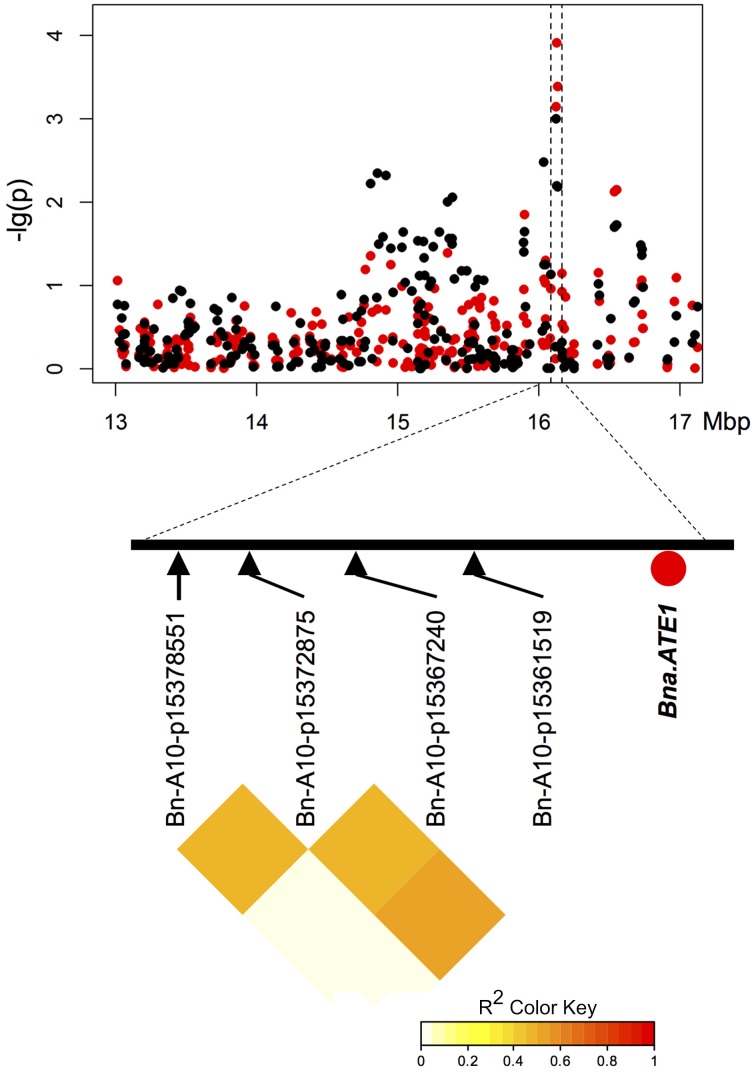
Manhattan plot describing marker-trait associations for the trait ES for the chromosomal region around candidate BnaA10g24850D (Bna.ATE1) on chromosome A10, and correlations between markers of the linkage group harboring BnaA10g24850D. Red dots represent associations calculated for SL2011. Black dots represent associations for SL2012.